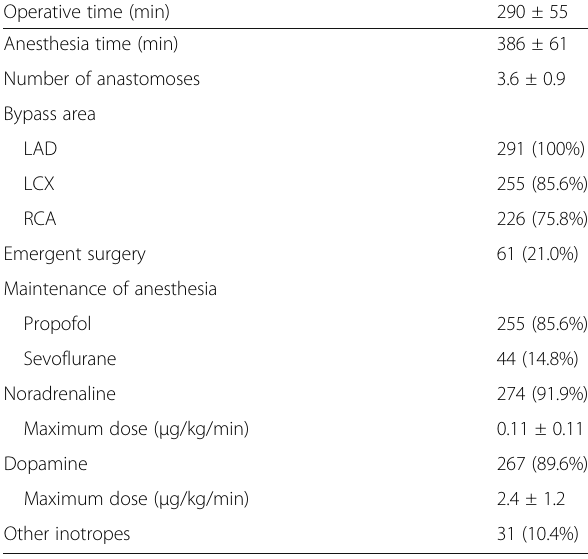
Table 2 Clinical features of the surgery and anesthesia ( n = 298) Operative time